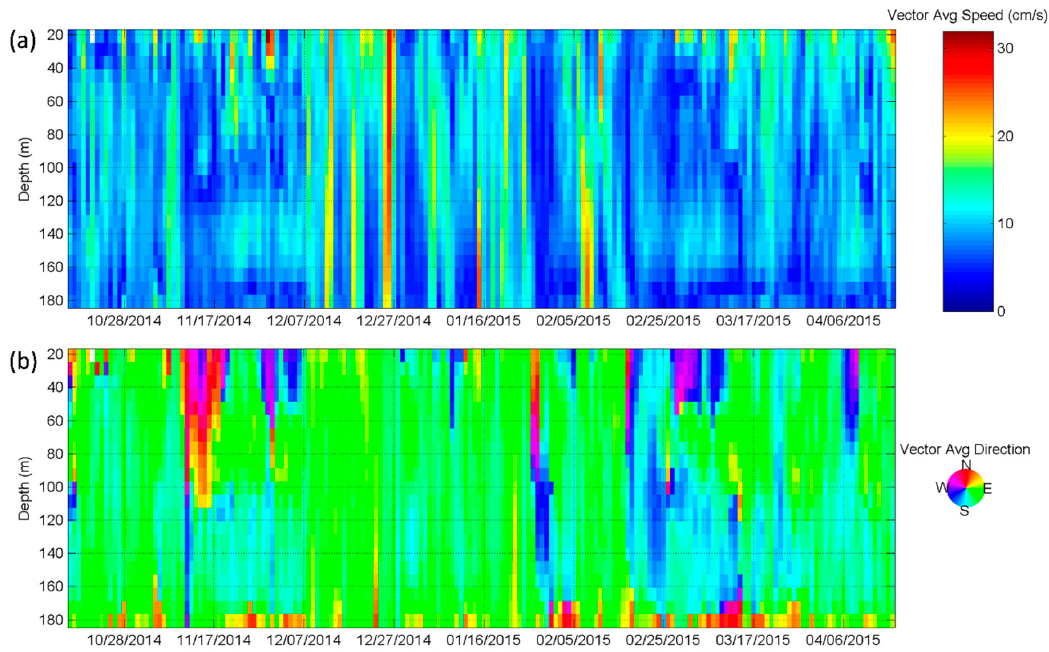
Figure 10. Daily vector average current ( a ) speed and ( b ) direction for the full water column.